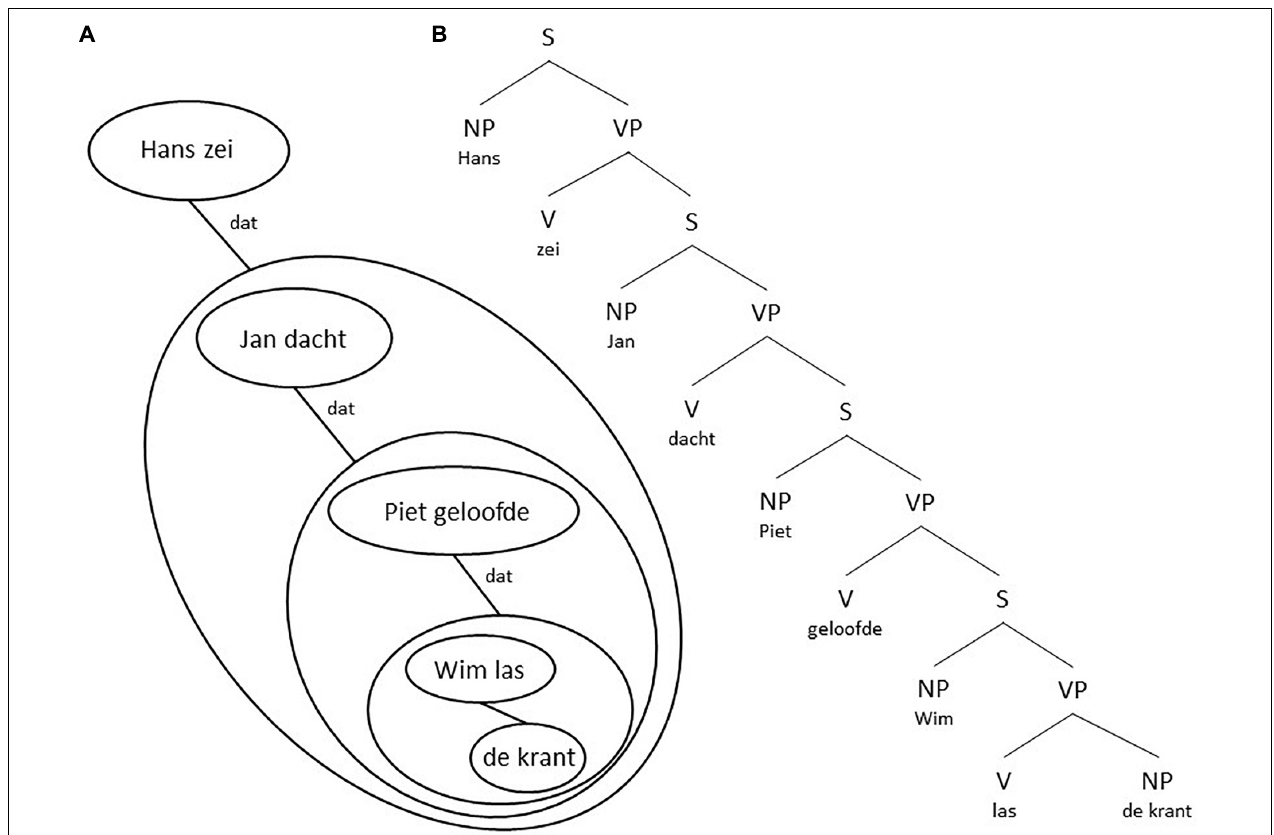
FIGURE 9 | A structural representation of utterance (8a) according to Focus: (A) its chunking structure and (B) a related grammar